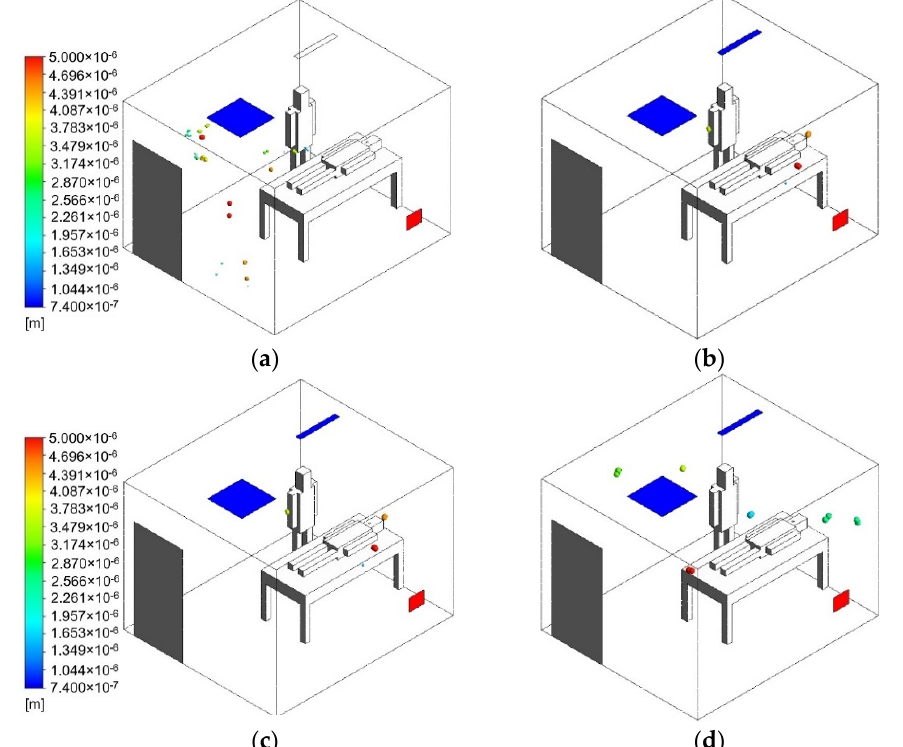
Figure 9. Particle trajectory pathway from the patient (at 120 s): ( a ) without air curtain ( b ) V = 0.5 m/s; ( c ) V = 0.75 m/s; ( d ) V = 1.0 m/s.